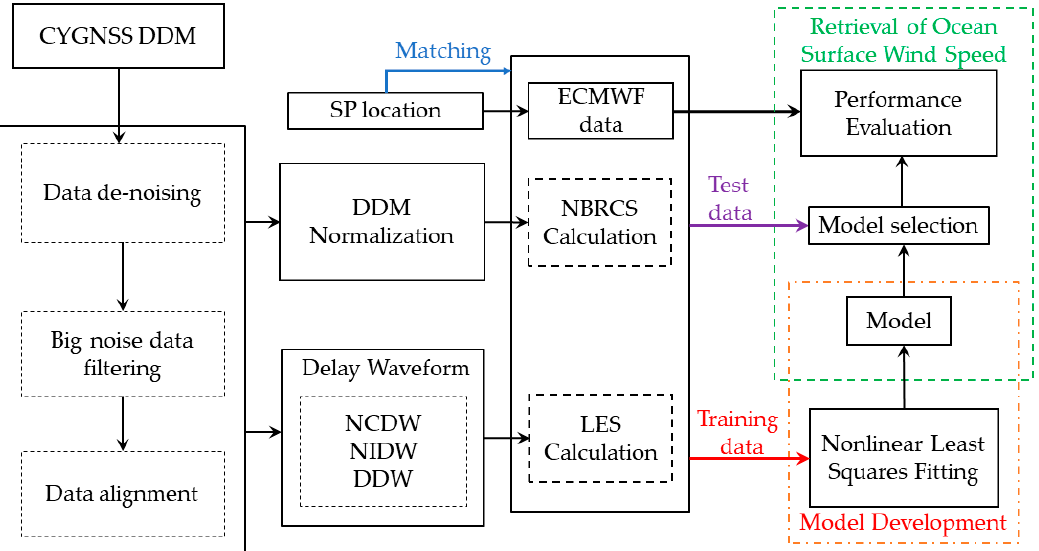
Figure 7. Flow chart of wind speed estimation model construction. The first stage is data preprocessing. The second stage is data matching. The third stage is the model development process (marked in the orange box) and the model selection and performance evaluation (marked in the green